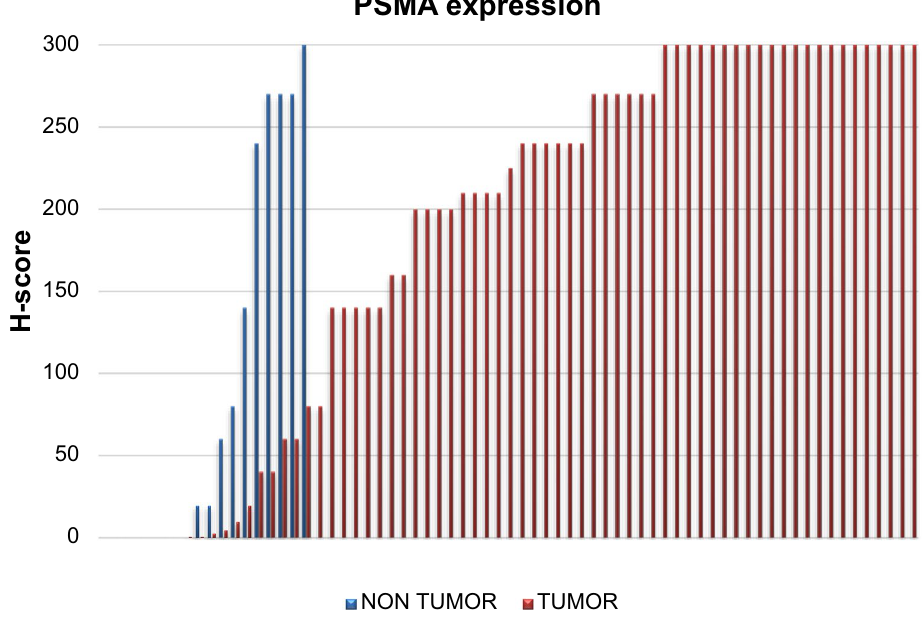
Figure 1. Data distribution in terms of PSMA H-score of non tumor (no. 18) and tumor samples (no.